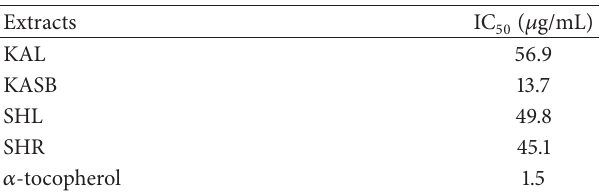
Table 4: Free radical scavenging activities of methanol leaf extract (KAL) and stem bark extract (KASB) of K. africana and leaf extract (SHL), root extract (SHR) of S. hispidus and 𝛼 -tocopherol determined by DPPH